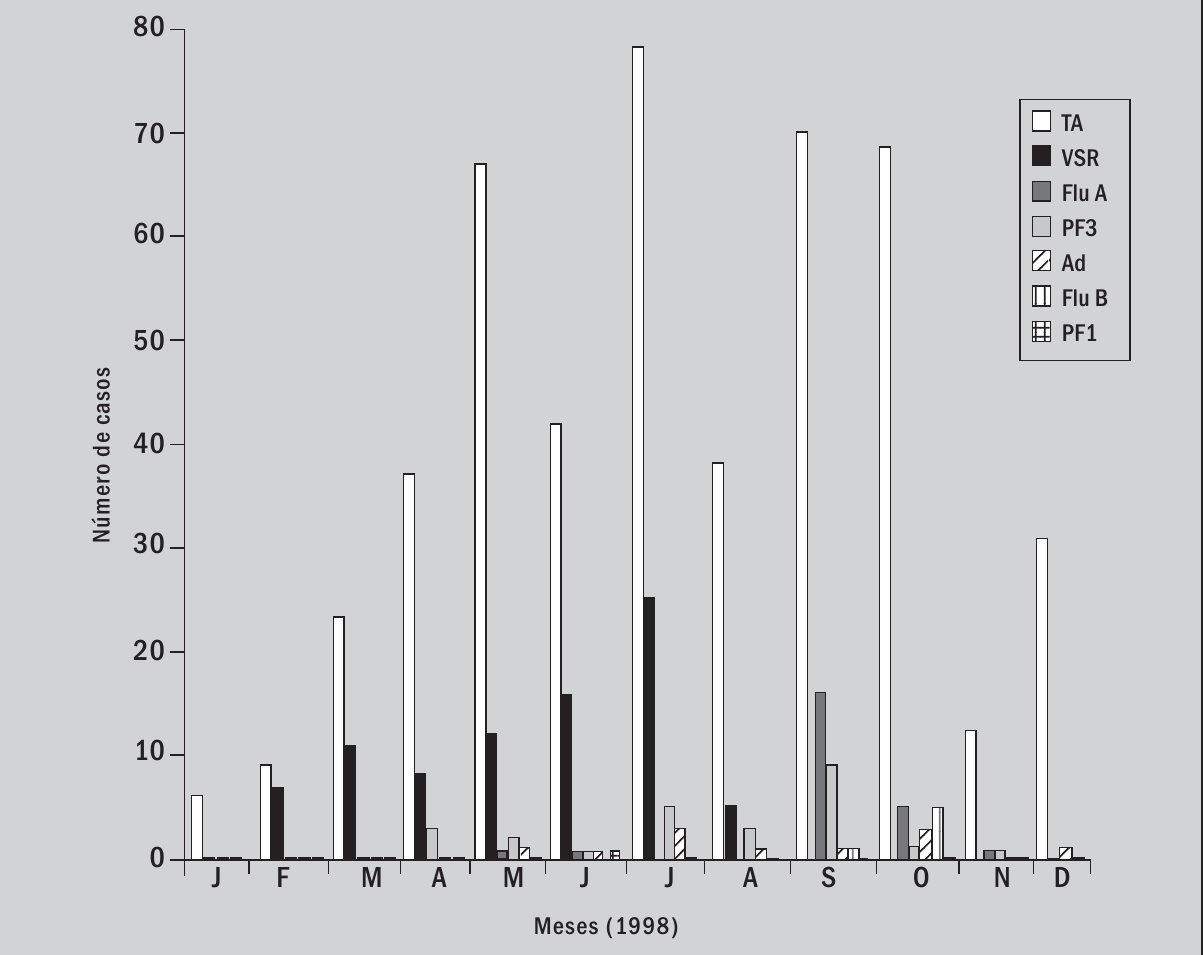
Figura – Distribuição mensal dos vírus identificados em 482 casos de infecção respiratória aguda em crianças atendidas no Centro Pediátrico Professor Hosannah de Oliveira, da Universidade Federal da Bahia, em Salvador, durante o período de janeiro a dezembro de 1998 (VSR = vírus sincicial respiratório; Ad = adenovírus; Flu A = influenza A; Flu B = influenza B; PF1= parainfluenza 1; PF3 = parainfluenza 3; TA = total de